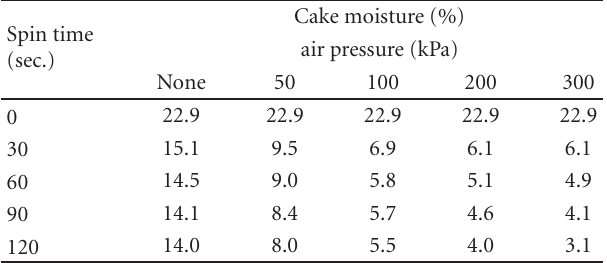
Table 8: E ff ects of G -force and air pressure on the dewatering of